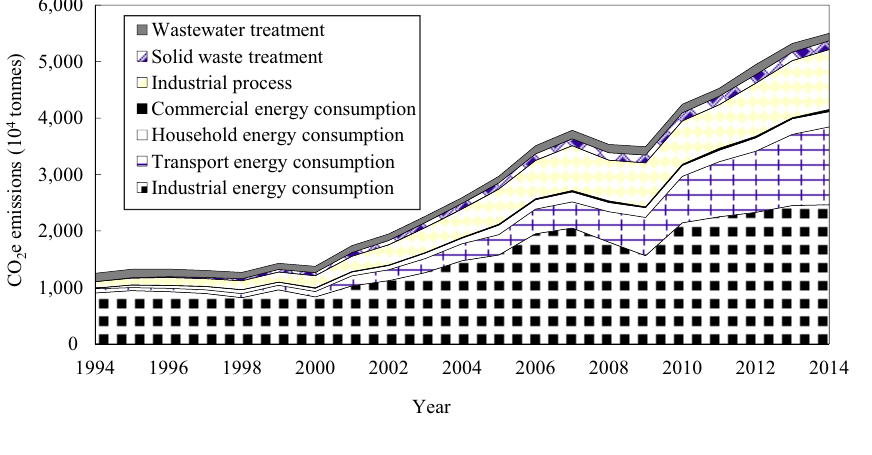
Figure 9. Total CEs and different subsector CEs in Nanchang